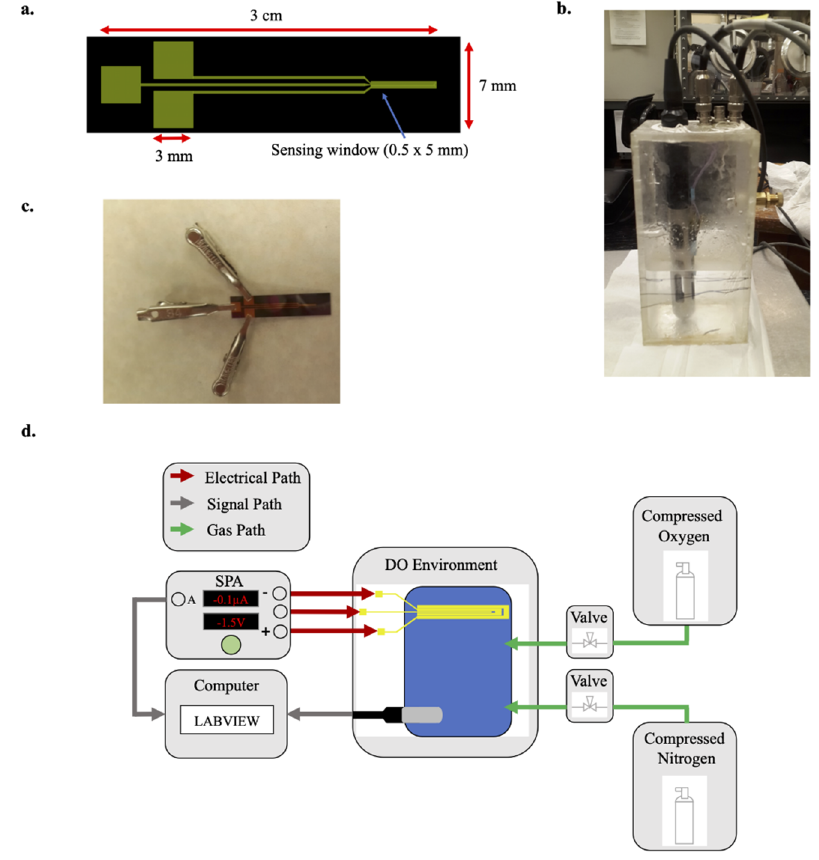
Figure 3. ( a ) CAD drawing of the standard overall electrochemical sensor geometry, featuring the sensing window and electrode contact pads. ( b ) Experimental setup, featuring the YSI ProDo Optical Probe in solution alongside the dissolved oxygen sensor. The container also had input ports for nitrogen and oxygen gas. ( c ) The sensor chip with metal leads attached for forming the biasing and sensing circuit with the SPA. ( d ) The overall electrical, signal, and gas paths throughout the experimental setup.